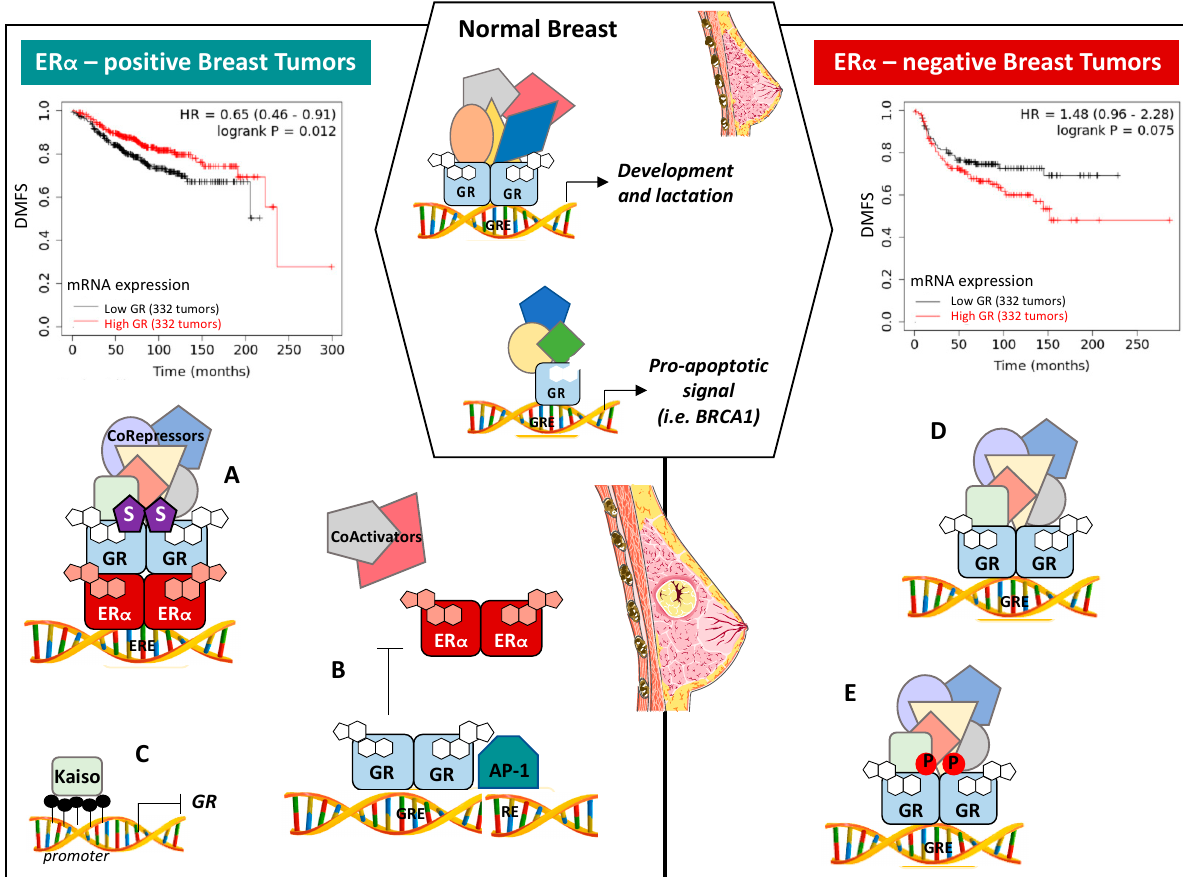
Figure 5. GR involvement in physiological and pathophysiological breast functions. Mammary gland development and lactation are regulated by GR in normal breasts. In addition, unliganded GR binds to the promoter region of some pro- apoptotic genes, such as BRCA1 , upregulating their expression in non-malignant mammary cells. GR controls the outcome of BC depending on the ER α status of the tumor. In ER α -positive BCs, GR regulates the repression of the ER α transcriptional program by directly binding to ER α , promoting its sumoylation (S) and recruitment of corepressors ( A ), or in a composite manner by directly binding to AP-1 ( B ). In addition, in ER α -positive breast cancer cells, methyl-CpG islands in the GR promoter work as a binding site for Kaiso, resulting in the repression of GR expression ( C ). Conversely, in ER α -negative BCs, GR regulates pro-tumorigenic genes and is associated with a worse prognosis ( D ), and pS134-GR is found to be higher in TNBC in comparison with luminal BCs and associated with a migratory phenotype ( E ). Kaplan–Meier curves were built using KM plotter database [103].